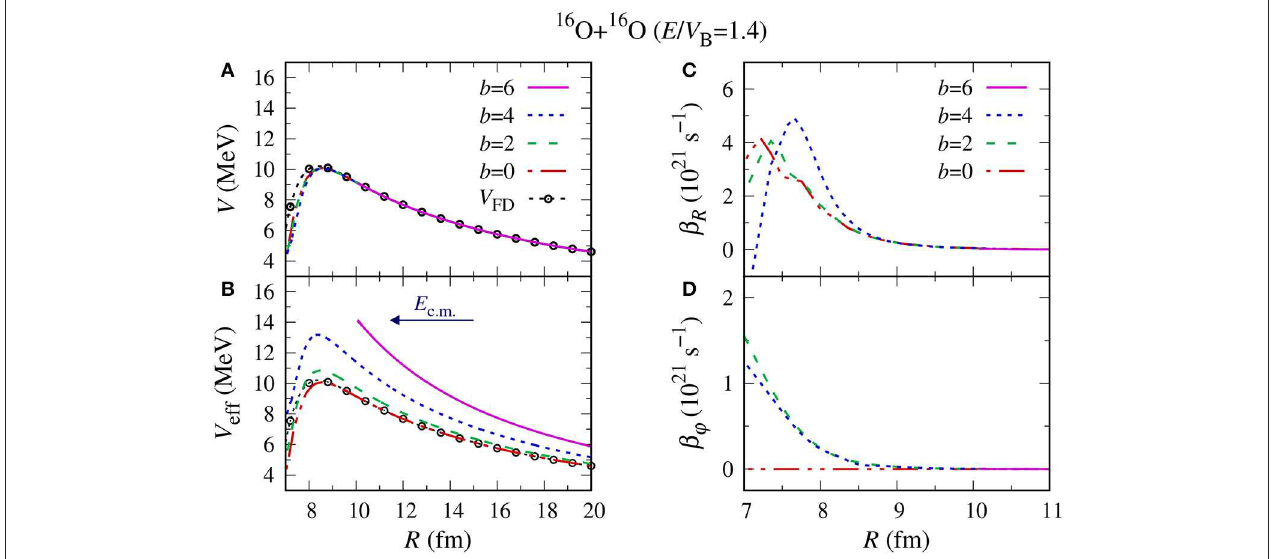
FIGURE 2 | Results of DD-TDHF calculations for the 16 O+ 16 O reaction at E / V B = 1.4 at various impact parameters. The nucleus–nucleus potentials and the effective potential V eff ( R ) = V ( R ) + L 2 / 2 µ R 2 are shown in (A,B) , respectively, as a function of the relative distance, R . The reduced radial friction coefficients, β R = γ R /µ , are shown in (C) , while the reduced tangential friction coefficients, β ϕ = γ ϕ /µ , are shown in (D)